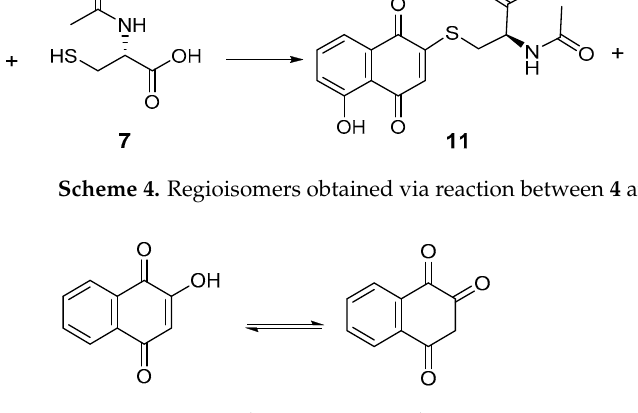
Figure 3. Keto–enol tautomerism in lawsone. Table 1. Reactions between 1 – 6 and 7 in ethanol at different